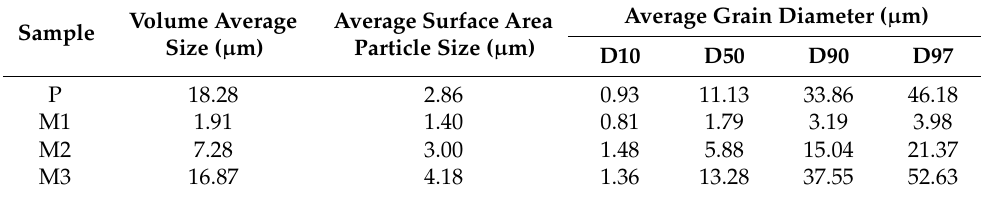
Figure 2. XRD of the marble waste powder. Table 1. Sample particle size distribution.